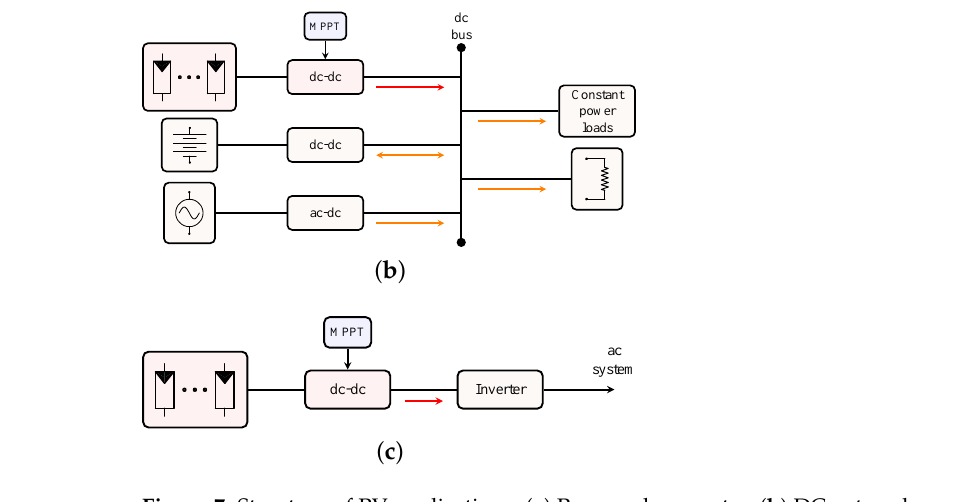
Figure 7. Structure of PV applications. ( a ) Proposed converter. ( b ) DC network application. ( c ) Grid- connected PV